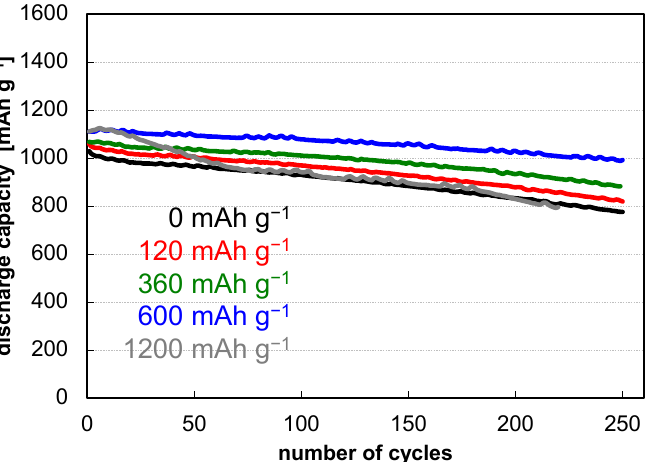
Figure 8. Cycling behavior of full cells (discharge capacity of anode active material) with prelithiated anodes based on standard CLM00001 with different prelithiation levels, voltage range 4.2–3.0 V. Appropriate prelithiation has been found to compensate for continuous lithium loss and strongly increases cycle life.